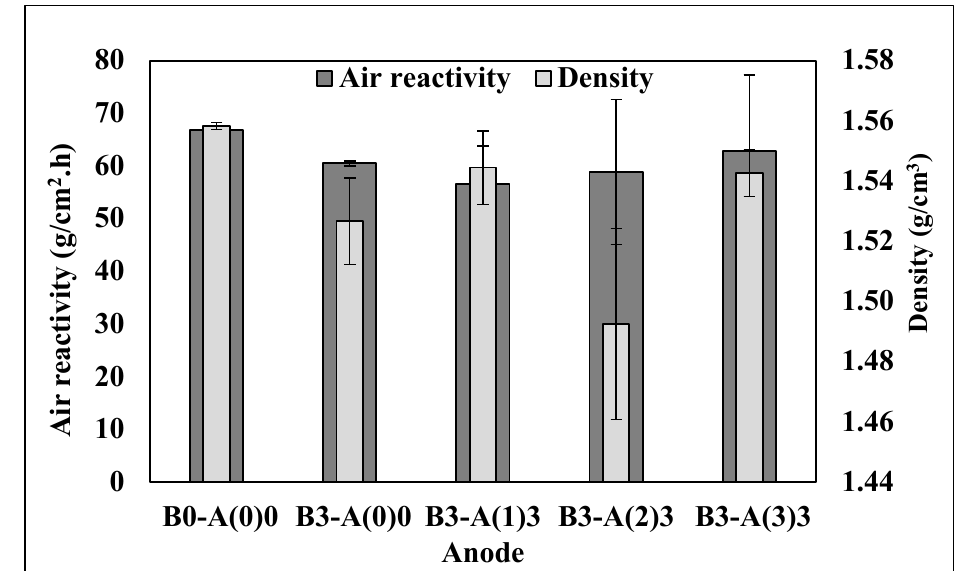
Figure 4. Air reactivity of the anodes.